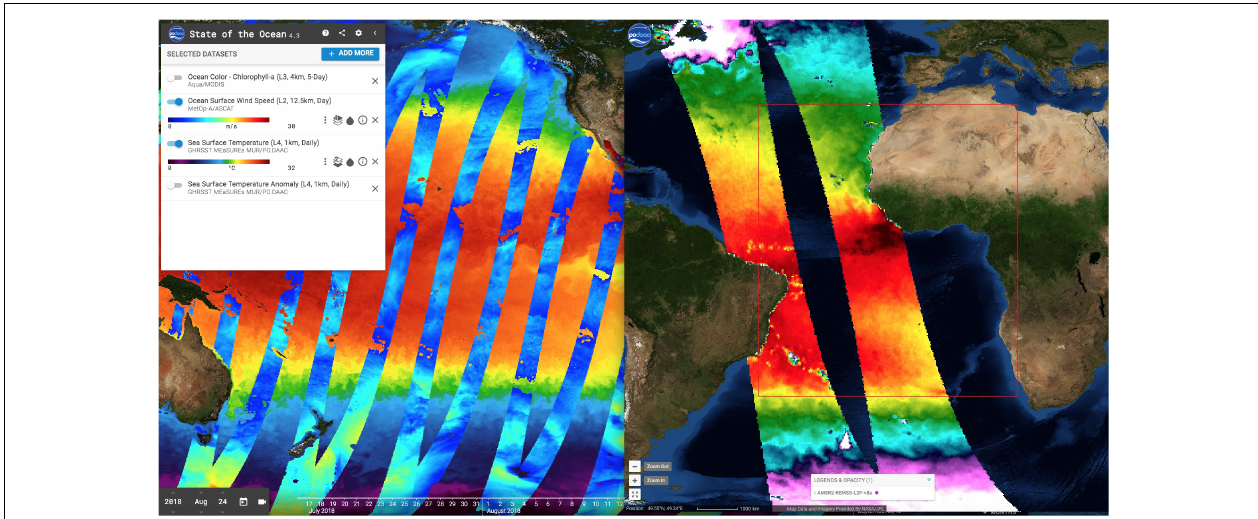
FIGURE 8 | The SOTO visualization tool (left) showing an overlay of ocean wind satellite tracks over a global Level 4 daily SST map juxtaposed with output from the HiTide Level 2 subsetter (right) showing two AMSR2 SST swaths overlapping a region of interest off